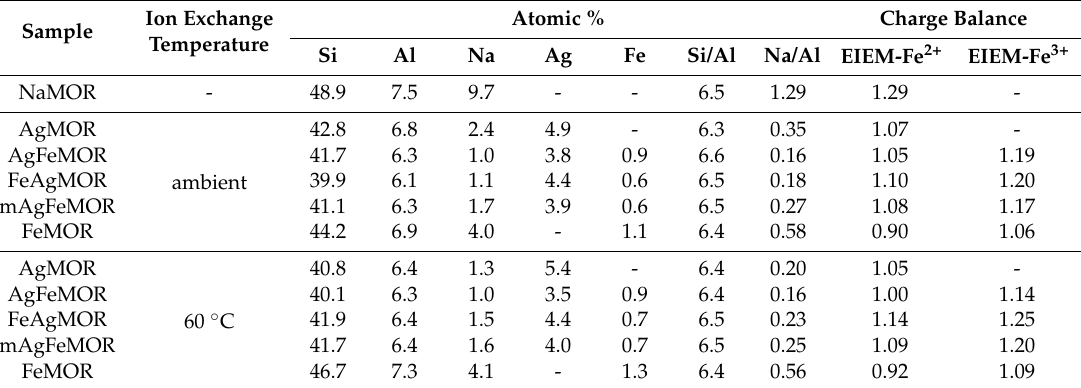
Table 2. Elemental composition by ICP-OES of studied